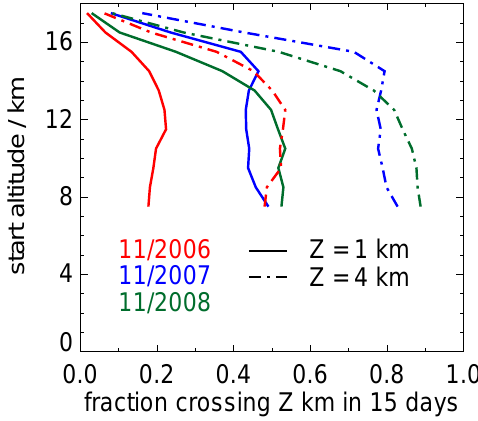
Fig. 3. For each of the three Novembers studied, the fraction of back trajectories starting in 1 km bins between 7–18 km that cross 1 km (solid lines) and 4 km (dot-dash lines) within 15 days.